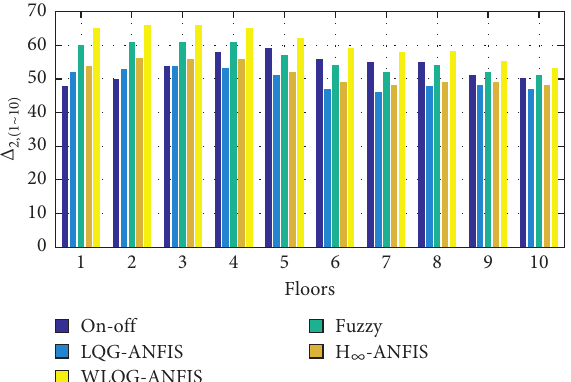
Figure 16: Performance indexes for five control strategies for all the interstory drifts.